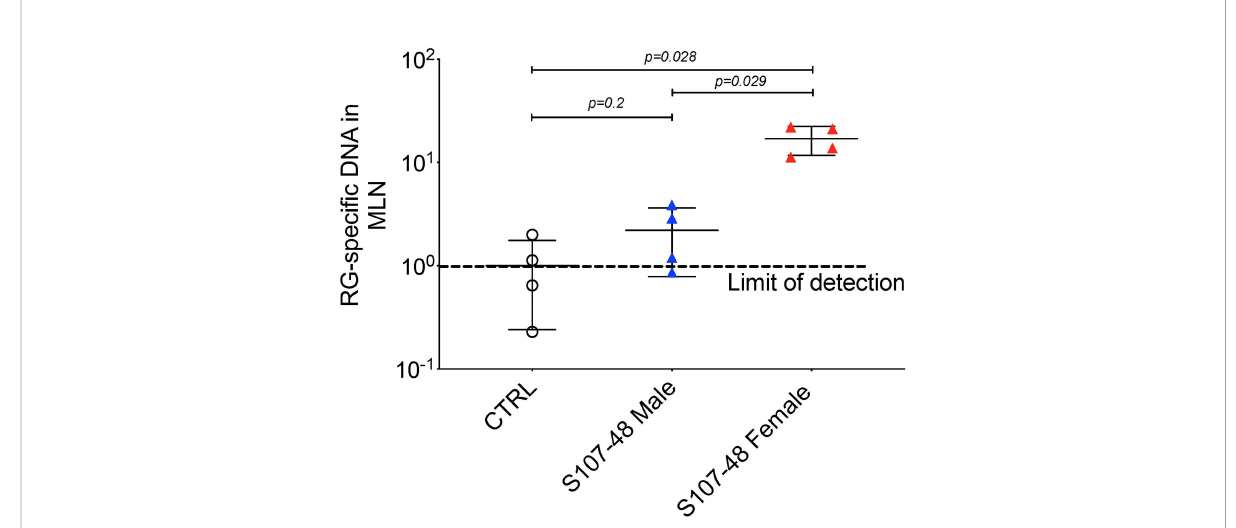
FIGURE 5 Translocation of S107-48 RG strain 16S rRNA gene DNA in female mice colonized by the S107-48 RG Lupus strain. Extracts of draining mesenteric lymph nodes (MLN) from female 14 wk-old littermates from GF mice colonized with the S107-48 RG strain demonstrate translocated RG genomic DNA into mesenteric lymph nodes ( p =0.001). Levels in females were signi fi cantly higher than in males ( p =0.002). Control RG2 and S47-18 were also tested at this late time point, but did not attain signi fi cance. Comparisons by unpaired t test. Methods are described in section Quantitative PCR analysis